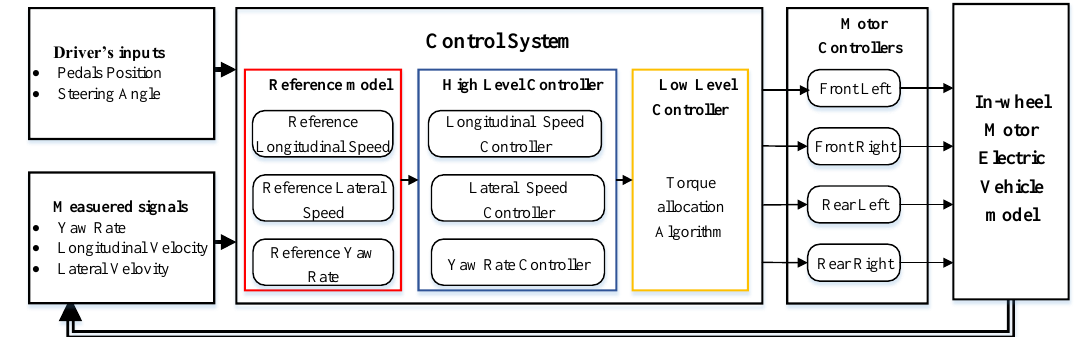
Figure 5. Process flow diagram of the driving control algorithm.